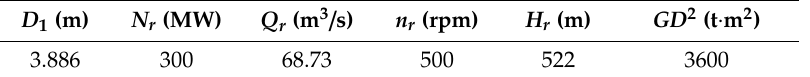
Figure 5. Arrangement of the diversion system of a pumped storage power station. Table 1. Rated parameters of water pump turbine.